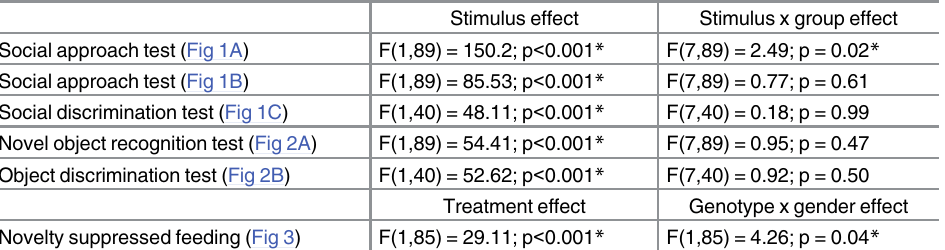
Table 1. Overall statistics for the behavioral data. Stimulus effect refers to both the empty cage and the same mouse (Fig 1A), to the novel and the same mouse/juvenile (Fig 1B/1C), and to the novel and the same object (Fig 2A and